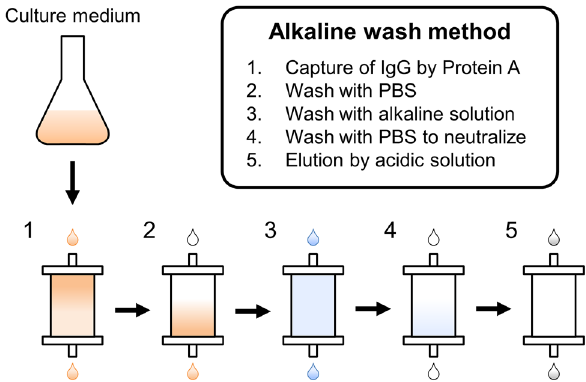
Figure 1. Schematic workflow for purifying antibody on Protein A with alkaline wash. (1) Culture medium was loaded onto the Protein A column equilibrated with PBS. The column was washed with (2) PBS and (3) alkaline solution (pH 11.0, unless otherwise indicated). (4) The column was then washed with PBS to adjust neutral pH. (5) Finally, the antibody was eluted with acidic